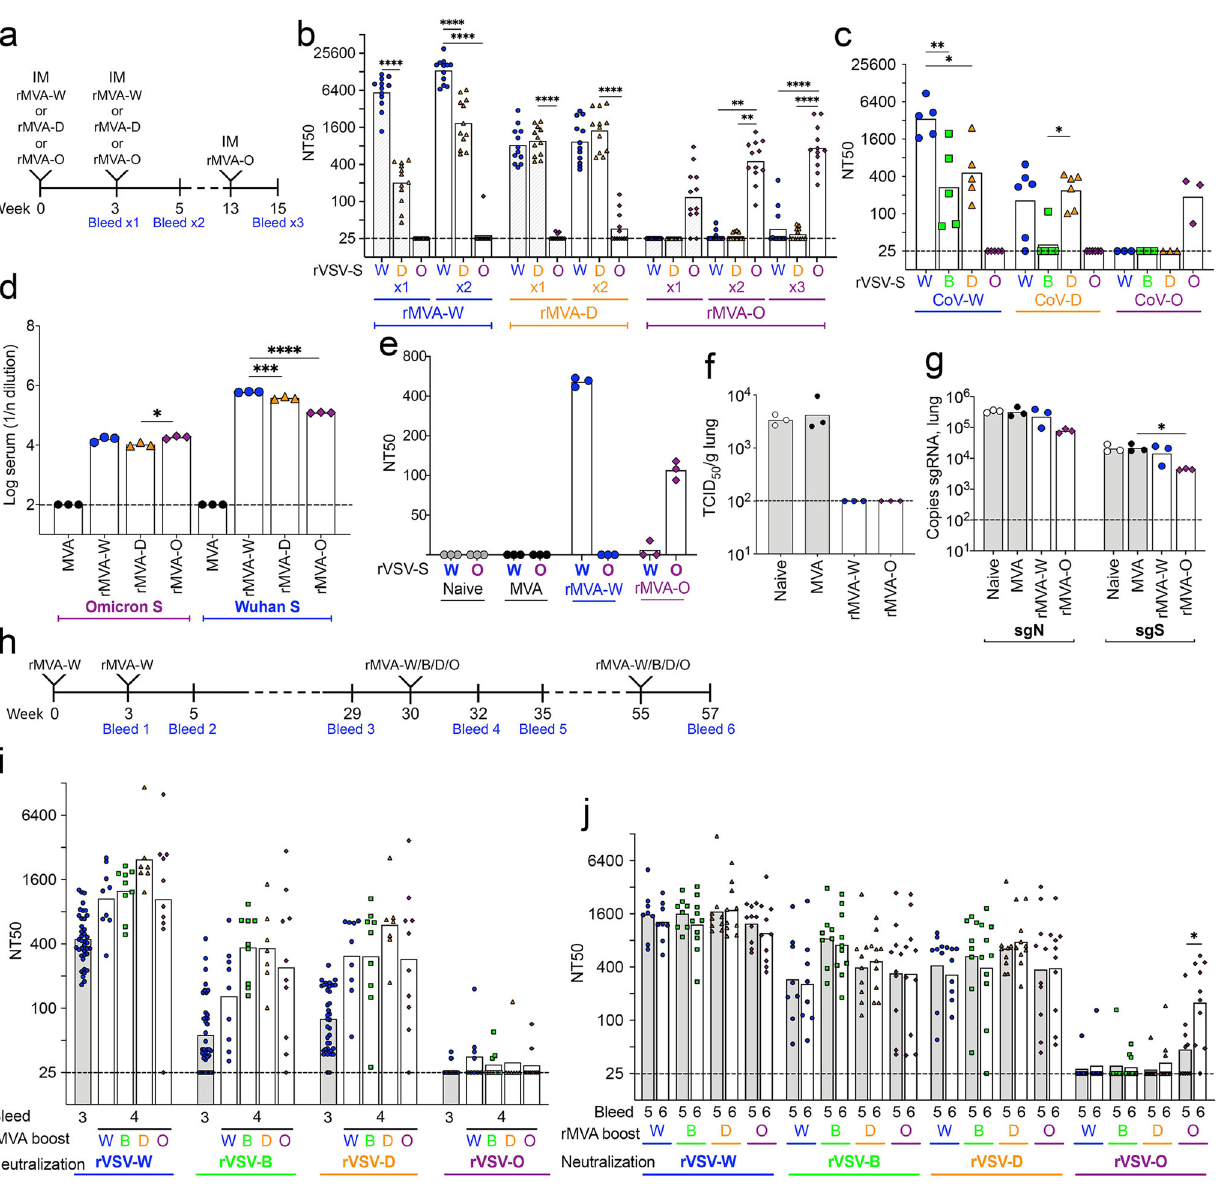
Fig. 5 Neutralizing antibody responses following boosts with rMVAs expressing matched or mismatched S. a Timeline of matched prime and boost IM vaccinations of C57BL/6 mice with 2 × 10 7 PFU of MVA or rMVA-W, -D, and -O. ( n = 10 per group). b Neutralization of pseudoviruses rVSV-W, -D and -O by serum obtained after the prime with rMVA-W, -D and -O and after the matched boost. n = 10 per group. c Neutralization of pseudoviruses by sera from mice sublethally infected with CoV-W, CoV-D or CoV-O in Supplementary Fig. 2. n = 3 to 5. d Binding of pooled serum from bleed 2 to Wuhan and Omicron S determined by ELISA. n = 3 per group. e Serum neutralizing titers of mice one day after receiving pooled serum IP from naive mice or mice immunized twice with MVA, rMVA-W or rMVA-O. n = 3. Recovery of f SARS- CoV-2 and g sgRNAs from the lungs at 4 days after challenge of passively immunized mice. h Timeline of C57BL/6 mice were immunized twice with rMVA-W and boosted with rMVA-W, -B, -D, or -O. n = 9 for rMVA-W and n = 10 for other rMVAs. i Neutralization of pseudoviruses rVSV-W, -B, -D and -O by serum obtained after the third immunization (bleed 4). n = 9 for rMVA-W and n = 10 for other rMVAs. j Neutralization of pseudoviruses by sera obtained after the fourth immunization (bleed 6). n = 9 for rMVA-W and n = 10 for other rMVAs. Statistics: for b – d ANOVA with Dunnetts post-hoc. * p ≤ 0.03; ** p ≤ 0.002; *** p ≤ 0.0002; **** p < 0.0001. Dotted line, limit of from rMVA-O-vaccinated mice were >100 for rVSV-O and binding of sera to mismatched S proteins compared to their undetectable or barely detectable for rVSV-W (Fig. 5e). Because neutralizing ability may have signi fi cance for cross-protection of limitations of passive transfer, we were not able to administer in vivo. To investigate this, a passive transfer experiment was suf fi cient serum to raise the NT50s of matched sera to the levels carried out by intraperitoneal inoculation of pooled sera from achieved with active vaccination. Despite the difference in mice vaccinated IM with rMVA-W or rMVA-O into K18-hACE2 mice. neutralizing titers, no CoV-O was recovered from the lungs at One day after serum transfer and just before challenge with CoV- 4 days after challenge of mice receiving anti-Wuhan or anti- O, the NT50 values of the sera from rMVA-W-vaccinated mice were Omicron sera (Fig. 5f). However, the mice that received anti- >400 for rVSV-W and undetectable for rVSV-O (Fig. 5e). The Omicron serum also had slightly reduced sgN and sgS RNAs in the corresponding NT50 values for the mice receiving pooled sera